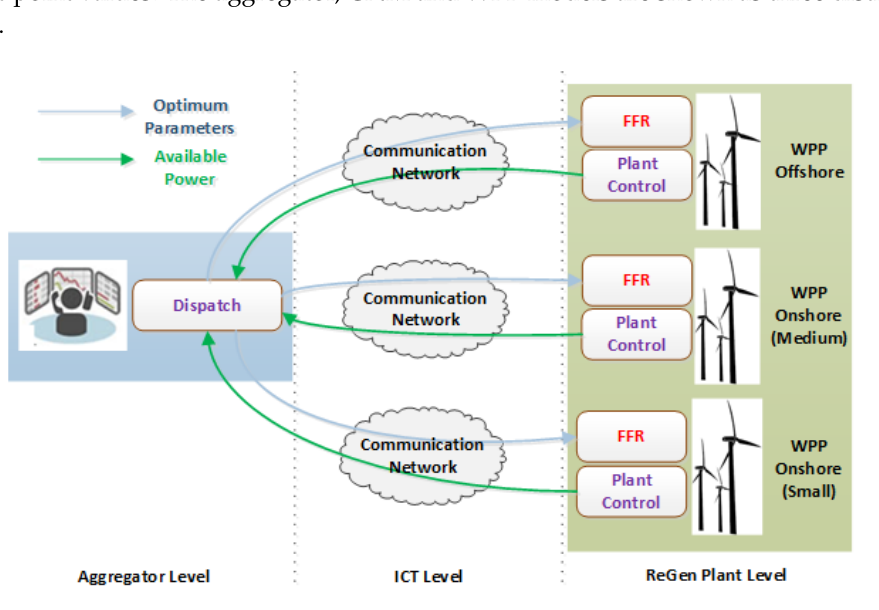
Figure 6. Simulation model with ReGen, ICT and aggregator control